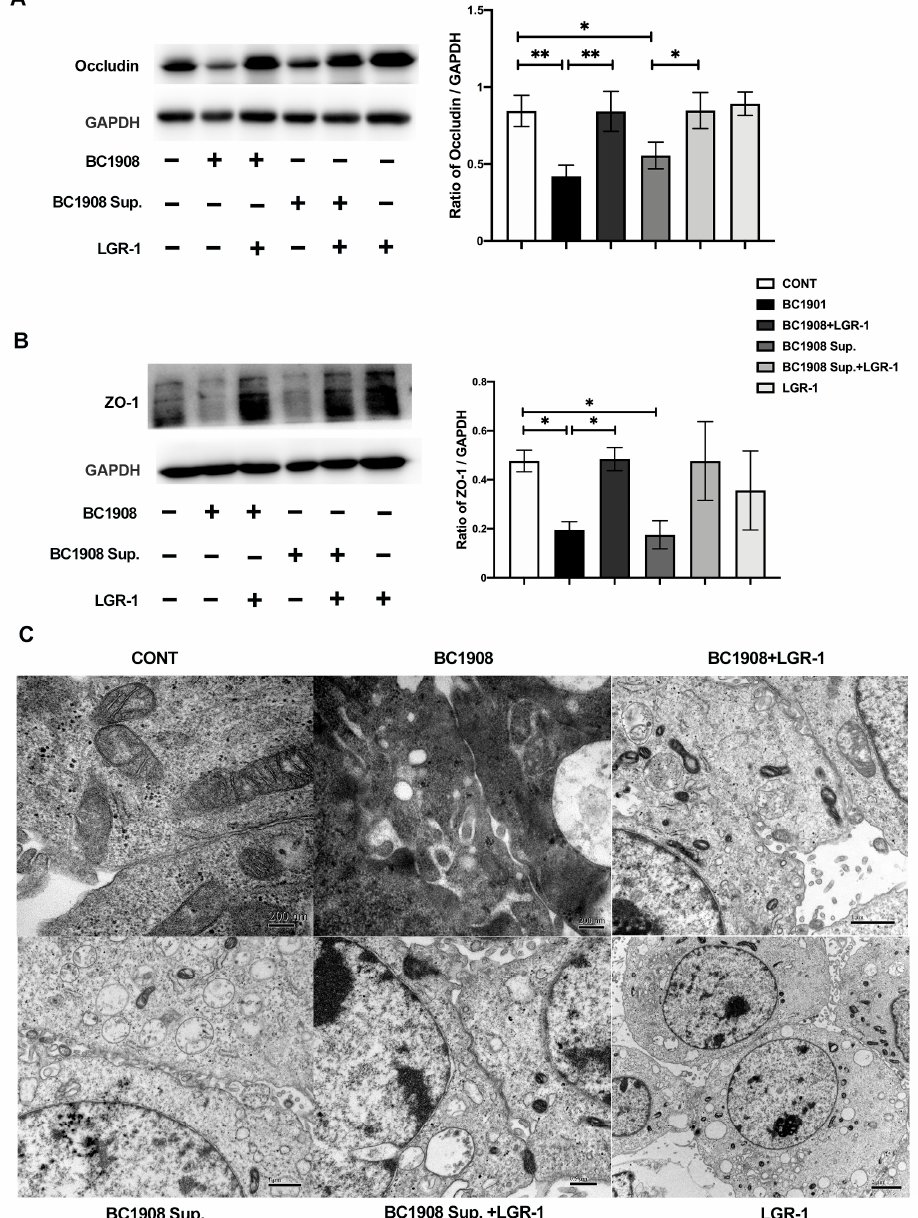
Figure 4. LGR-1 protects the destruction of the tight junction proteins, Occludin ( A ) and ZO-1 ( B ) caused by BC1908 and the supernatant of BC1908. ( C ) Transmission electron microscopy observed the tight junctions between cells with different treatments. (* p <0.05, ** p <